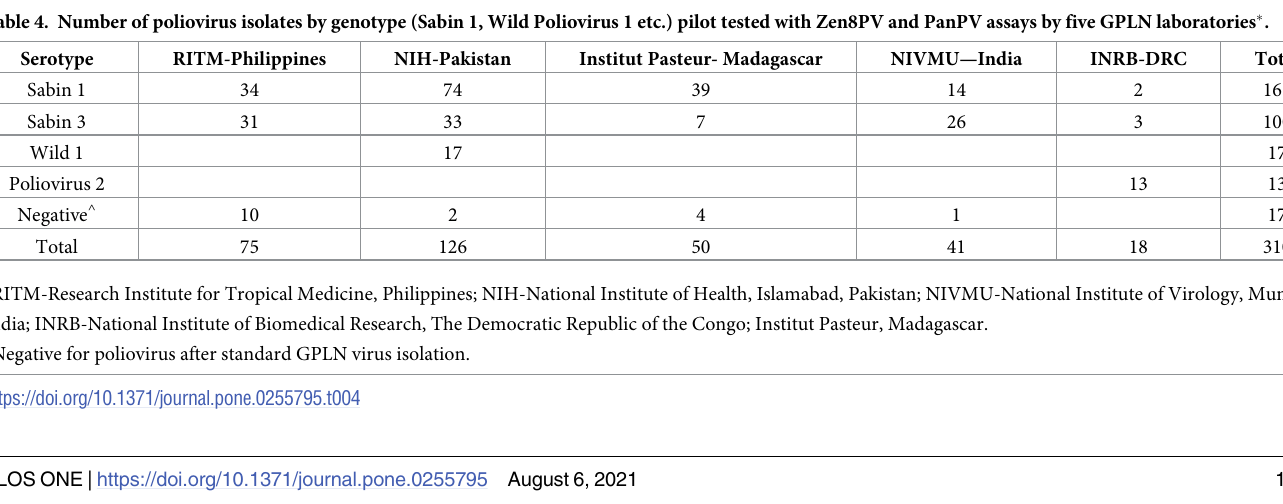
updated PanPV assay in the GPLN showed identical or better results compared to the previous